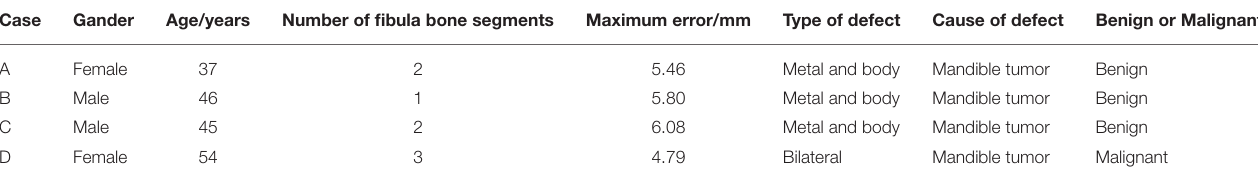
TABLE 1 | Information of the 4 patients and surgical results.